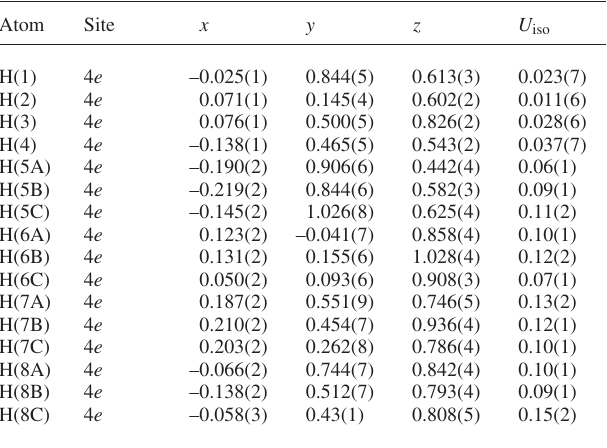
Table 2. Atomic coordinates and displacement parameters (in Å 2 )